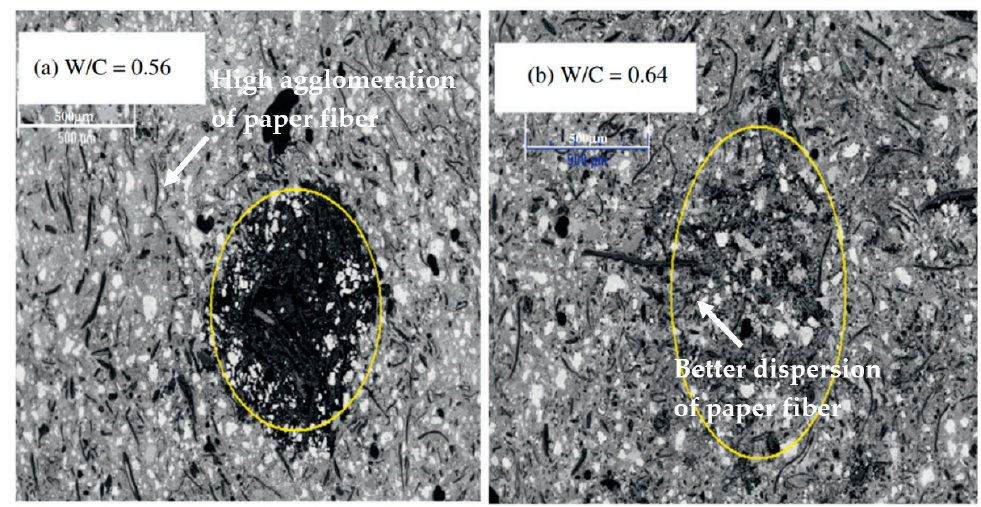
Figure 8. Microstructure of 10% replacement of waste paper fibres [30].